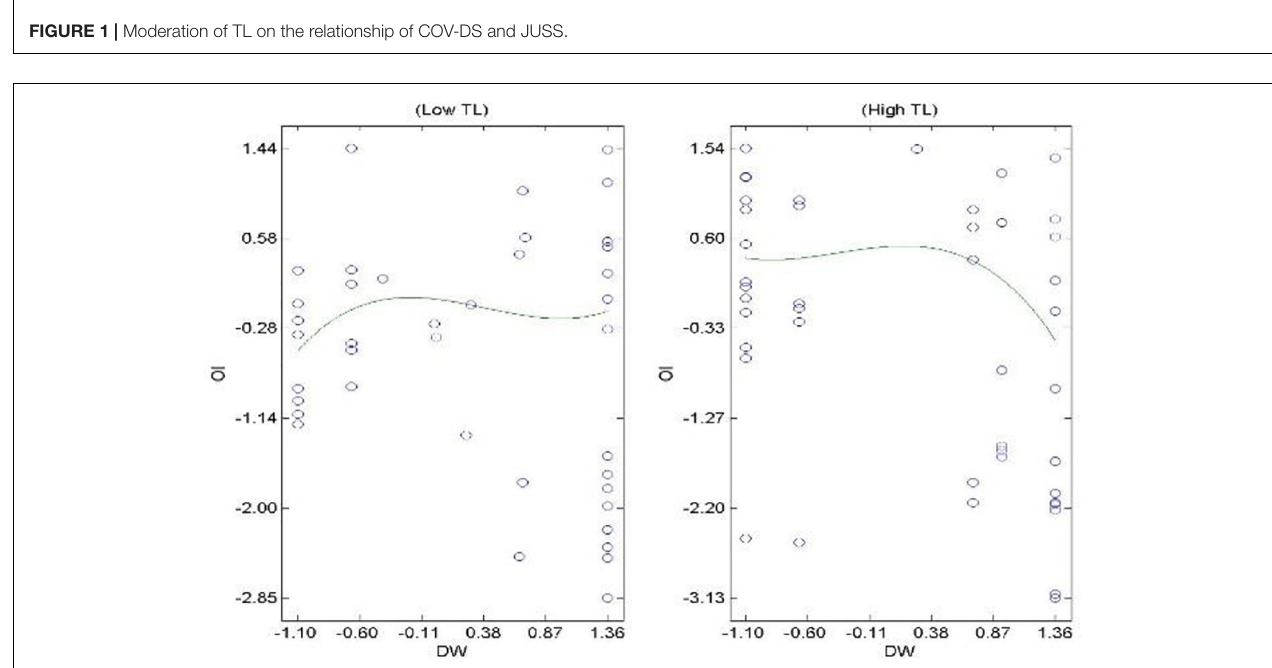
FIGURE 2 | Moderation of TL on the relationship of COV-DS and OIS.